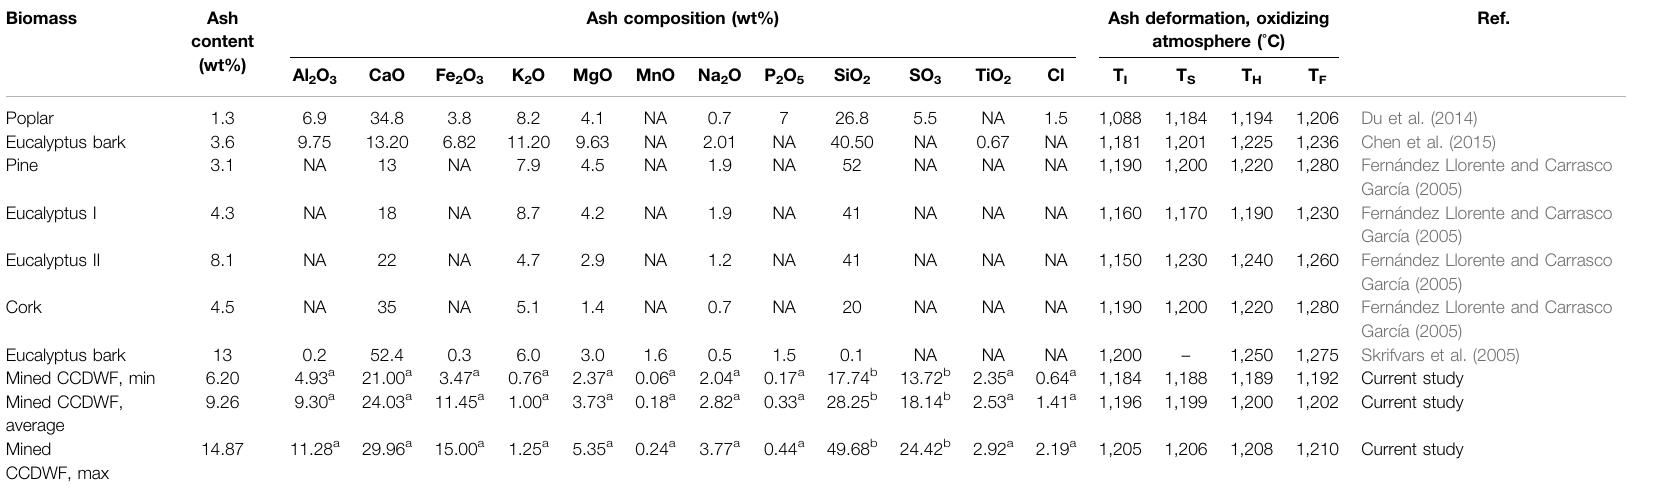
TABLE 7 | Ash composition and fusibility of a selection of biomass comparable to CCDWDF materials. Biomass Ash